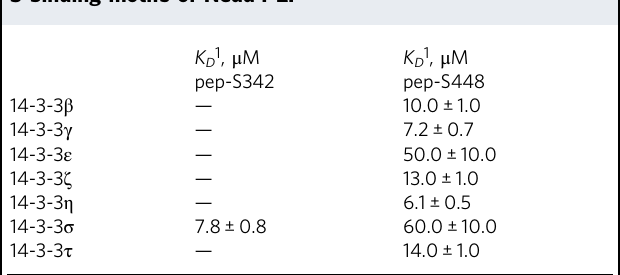
400 ± 100 nM and 530 ± 30 nM, respectively) in the singly